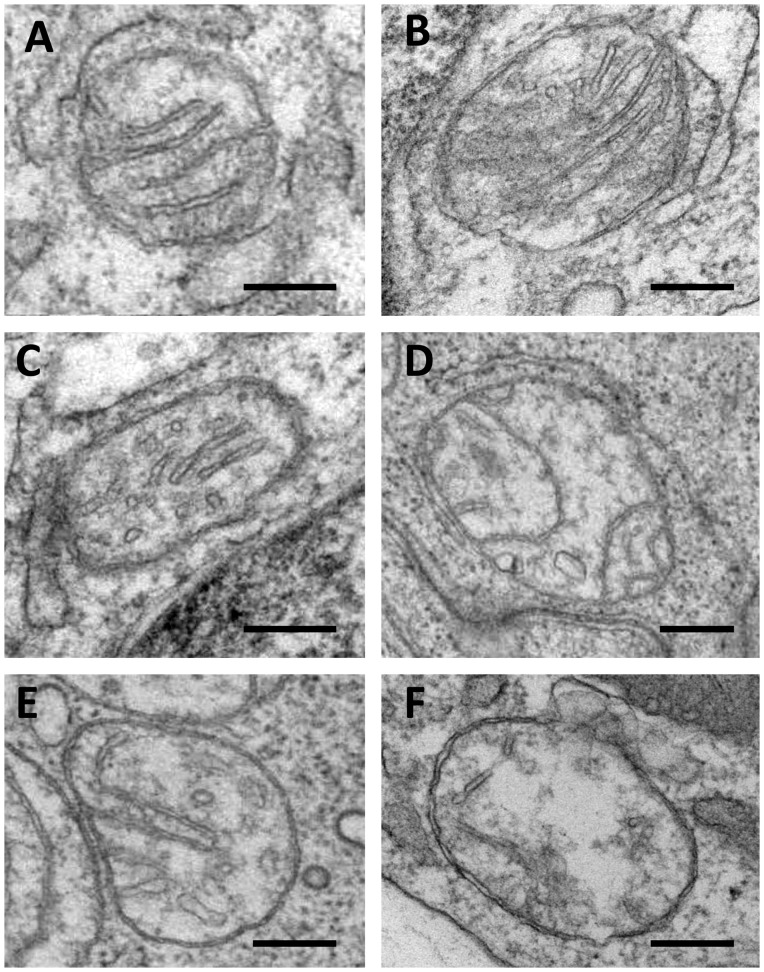
Different ultrastructural appearances of mitochondria in leukocytes obtained from healthy volunteers and patients with carotid atherosclerosis (A–F).(A): A mitochondrion with well-defined cristae and well-preserved surrounding membranes typically seen in leukocytes of healthy volunteers. (B–F): Mitochondria with reduced numbers of cristae and the oedema of the mitochondrial matrix observed in patients with carotid atherosclerosis (A–F): Electron microscopy. Scales = 150 nm.